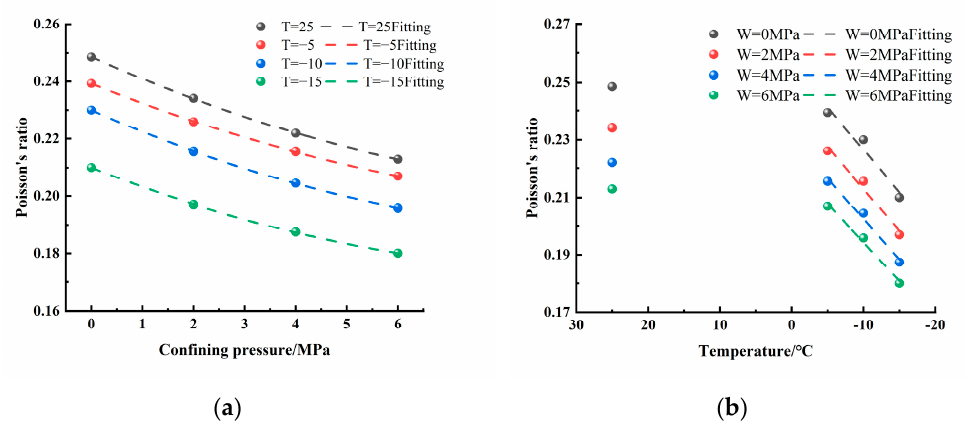
Figure 8. Poisson’s ratio of sandstone and the relationship between confining pressure and temper- ature. ( a ) Relationship between Poisson’s ratio and confining pressure. ( b ) Relationship between Poisson’s ratio and temperature.